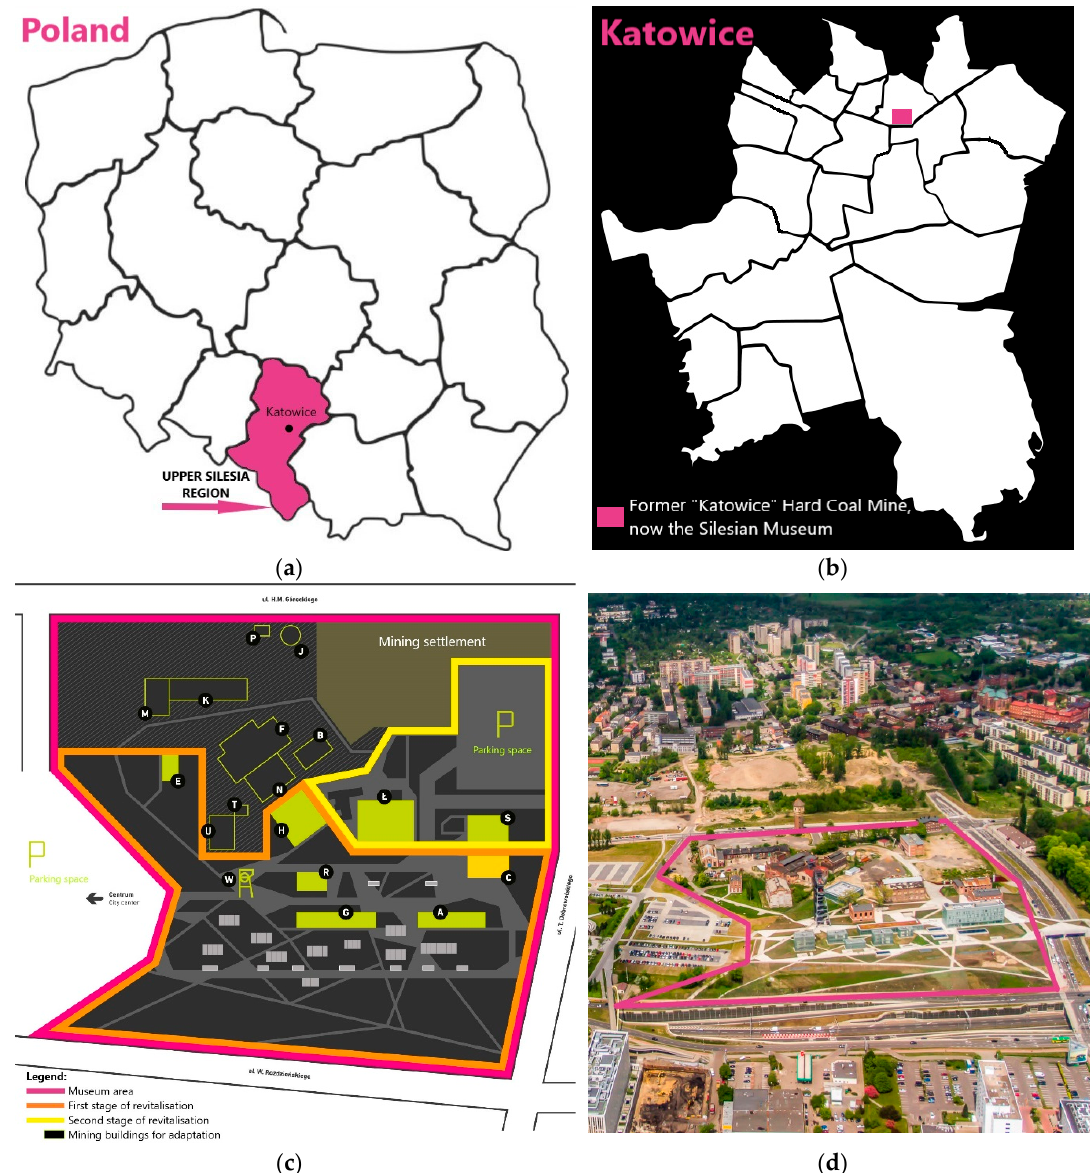
Figure 1. Research area location: ( a ) Location of Upper Silesia region and the city of Katowice in Poland; ( b ) Location of “Katowice” Hard Coal Mine, currently the Silesian Museum in Katowice; ( c ) Plan of the Silesian Museum with revitalisation (development) zones. Historical mining buildings: